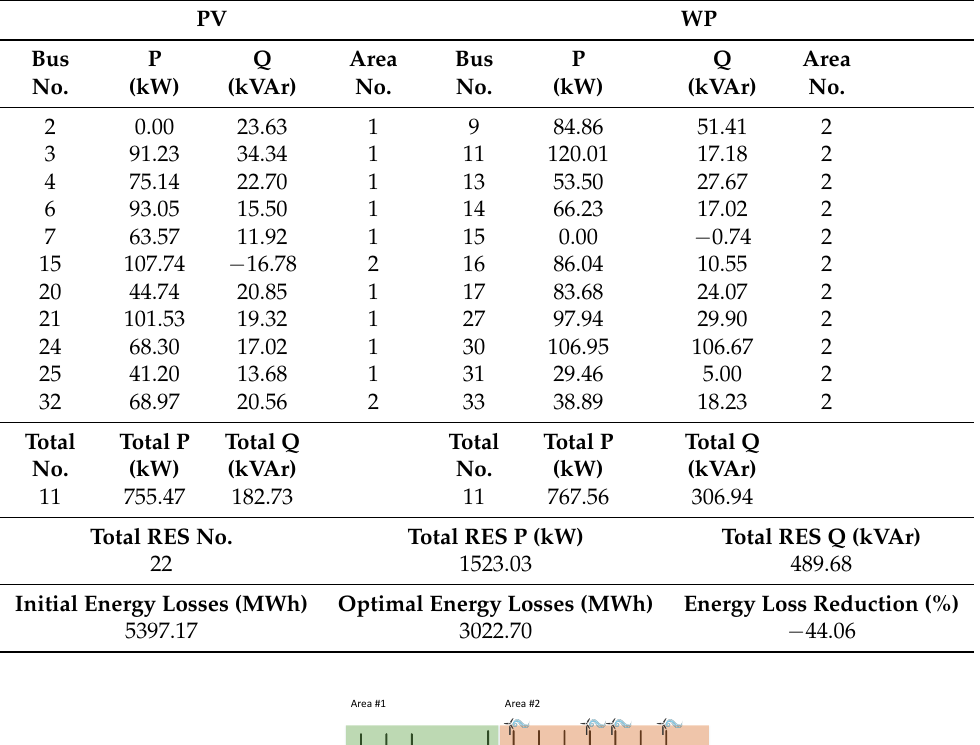
Table 18. Snapshot Approach—mean value—Scenario #1.